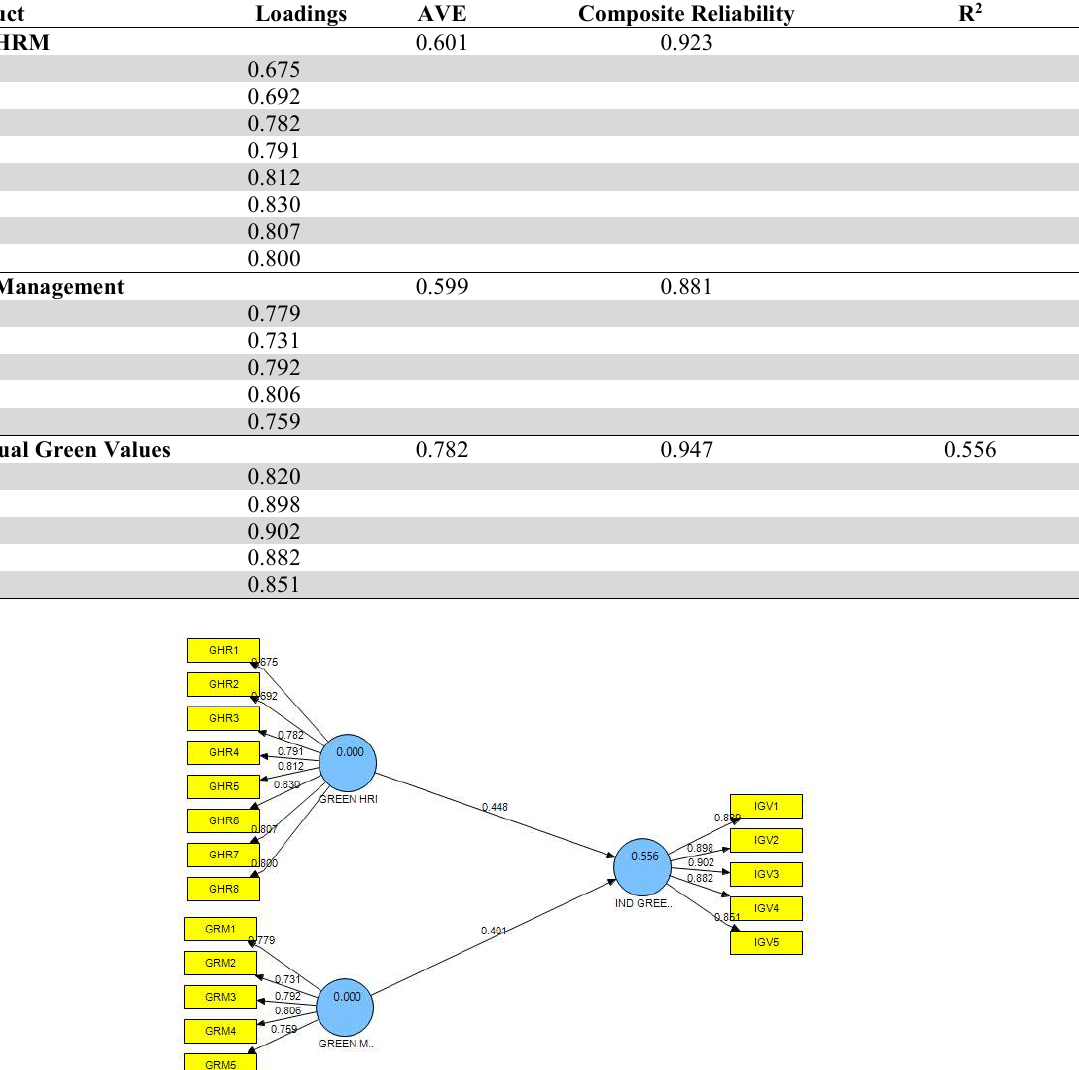
Fig. 1. Measurement Model